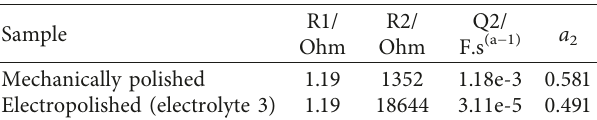
Table 4: The EIS parameters of mechanically polished and elec- tropolished Ti-6Al-4V SLM built